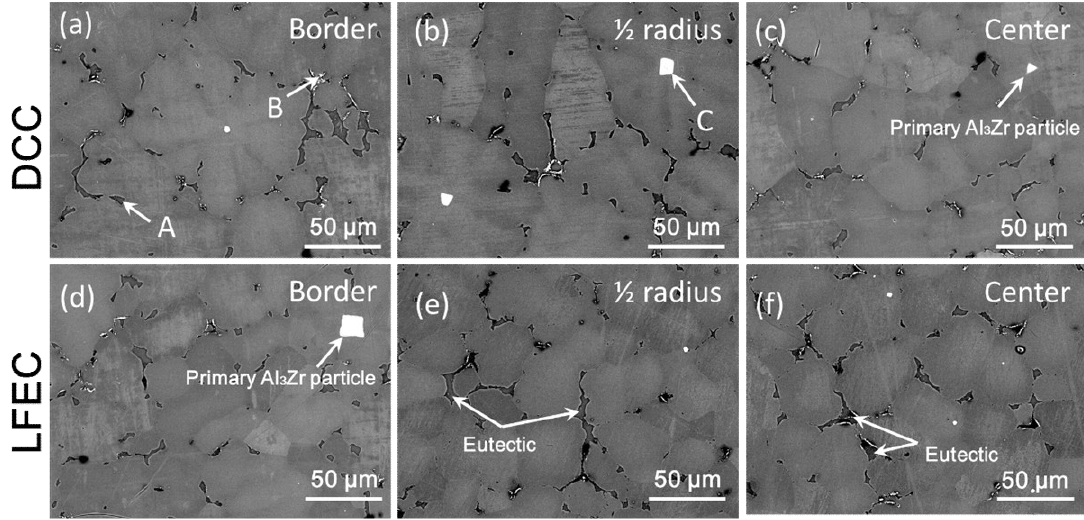
Figure 6. SEM images of 5A90 as-cast alloy. ( a ) DCC-border; ( b ) DCC-1/2 radius; ( c ) DCC-center; ( d ) LFEC-border; ( e ) LFEC-1/2 radius; ( f ) LFEC-center.